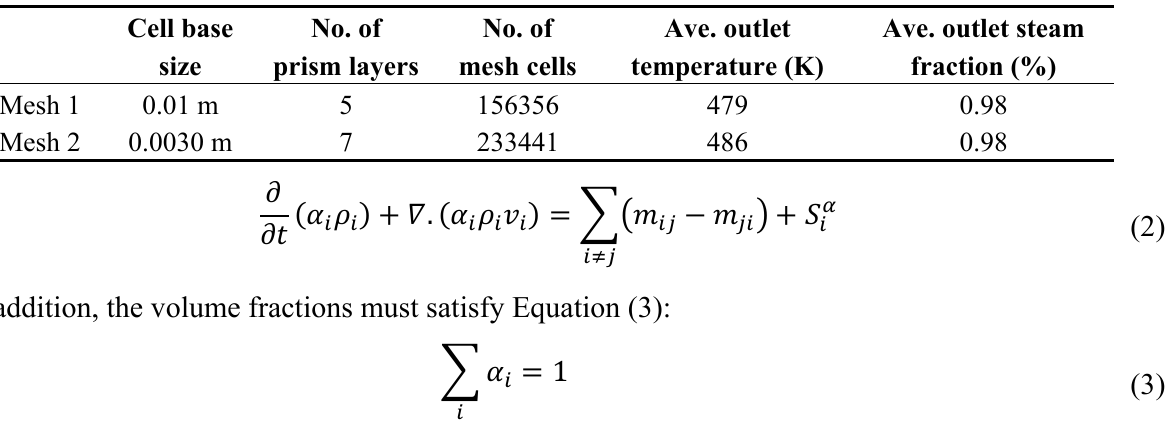
Table 2. Mesh specifications used in grid sensitivity